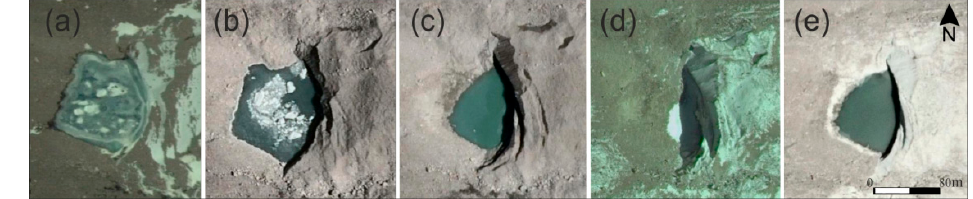
Figure 4. Satellite images from GoogleEarth ® : ( a ) 27.05.2012, ( b ) 01.10.2013, ( c ) 30.08.2014, ( d ) 06.10.2015, and ( e ) 13.08.2017.